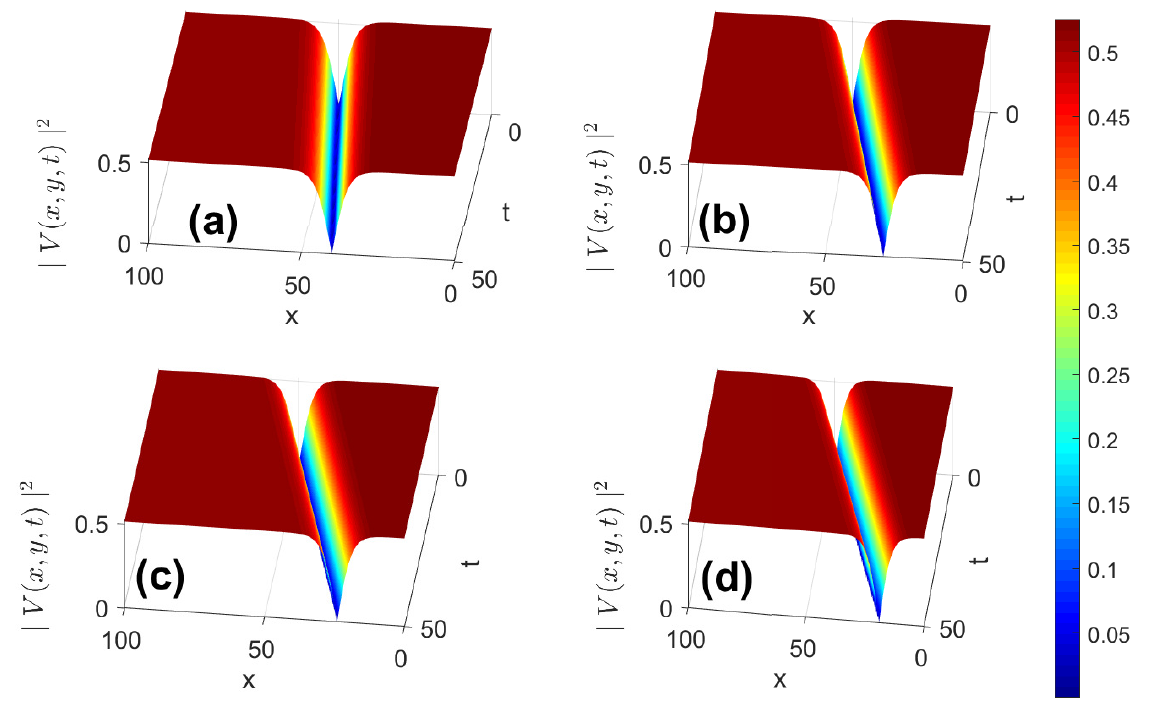
Figure 1. Spatiotemporal evolution of the dark soliton Equation (6) with variation in the poten- tial parameter α . ( a – d ) are, respectively, the values of the potential parameter. ( a ) α = 0.12 V − 1 , ( b ) α = 0.22 V − 1 , ( c ) α = 0.12 V − 1 , ( d ) α = 0.34 V − 1 . The parameters used are ϑ 0 = 0.2, β = 0.019 V − 1 , and B 1 =